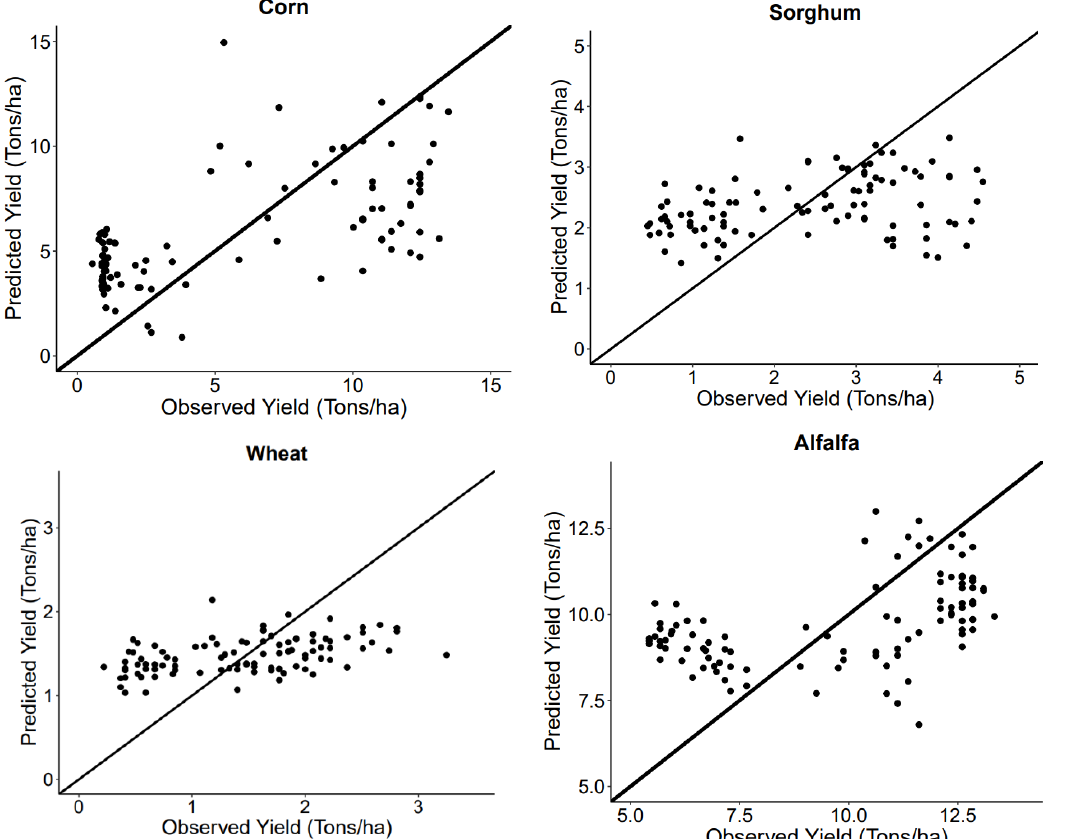
Figure 8. The scatter plot of observed and predicted corn, sorghum, wheat, and alfalfa yields resulting from the best models in long data period from 1920 to 2019.